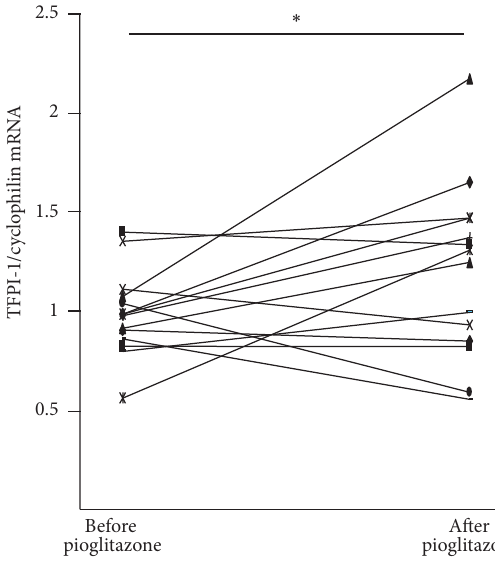
Figure 1: PPAR 𝛾 activation induces TFPI-1 expression in human blood mononuclear cells in vivo. RNA was extracted from PBMC isolated from 14 patients before and after 2 months of pioglitazone treatment (30mg/day). TFPI-1 mRNA levels were measured by Q- PCR and normalized to cyclophilin mRNA. Statistically significant differences are indicated ( 𝑡 -test; ∗ 𝑝 < 0.05